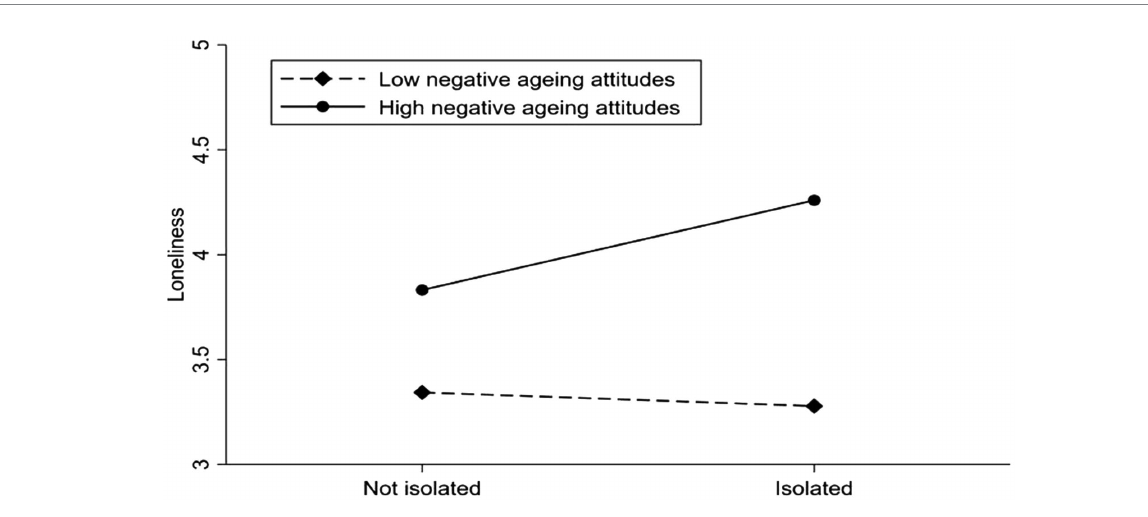
FIGURE 4 Loneliness among older adults who were not socially isolated or isolated with different levels of negative aging